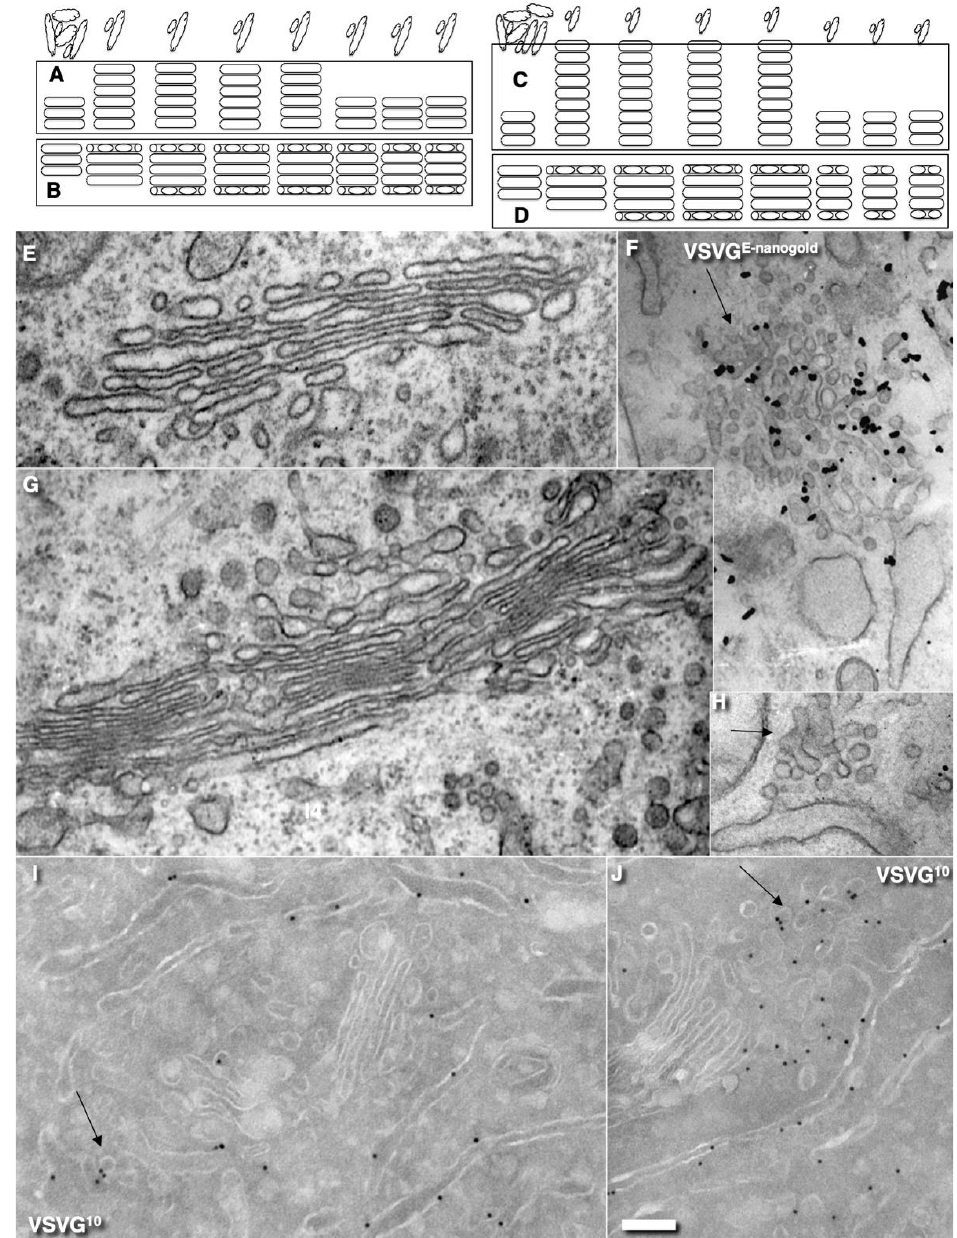
Figure 5. Dynamics of Golgi compartments during synchronous IGT. ( A – D ) Schemes of predictions related to the numbers of medial Golgi cisternae during IGT derived from the CMPM ( A , C ) and the KARM ( B , D ) during the mini-wave ( A , B ) and maxi-wave ( C , D ). According to the KARM, the number of medial Golgi cisternae remains constant both before and after the release of the transport block and does not depend on the amount of VSVG moving through the Golgi complex. The volume of the Golgi complex ( A ) and the surface area of the Golgi compartments ( B ) depends on the amounts of cargo transported (indicated in upper row). The KARM predicts that during the maxi-wave, the cisterna length would be higher than during the mini-wave. ( E – J ) Representative EM im-ages. ( E , G , H ) Routine EM. ( F ) Enhanced gold pre-embedding IEM (E-nanogold). ( I , J ) Tokuyasu cryo-sections. ( E ) The Golgi complex was small just before the release of the transport block ( F , G ), whereas the volume of the ERES was high ( F ). The Golgi volume increased after arrival of the cargo ( G ), whereas the volume of the ERES became small ( H ). Then the Golgi volume decreased again ( I ), whereas the volume of ERES became higher ( J ) if the delivery of the cargo was organised as a wave. Black arrows show ERES. Scale bars: 200 nm ( C , E , F , G ); 290 nm ( D ). Quantified in Figure 4H – K.